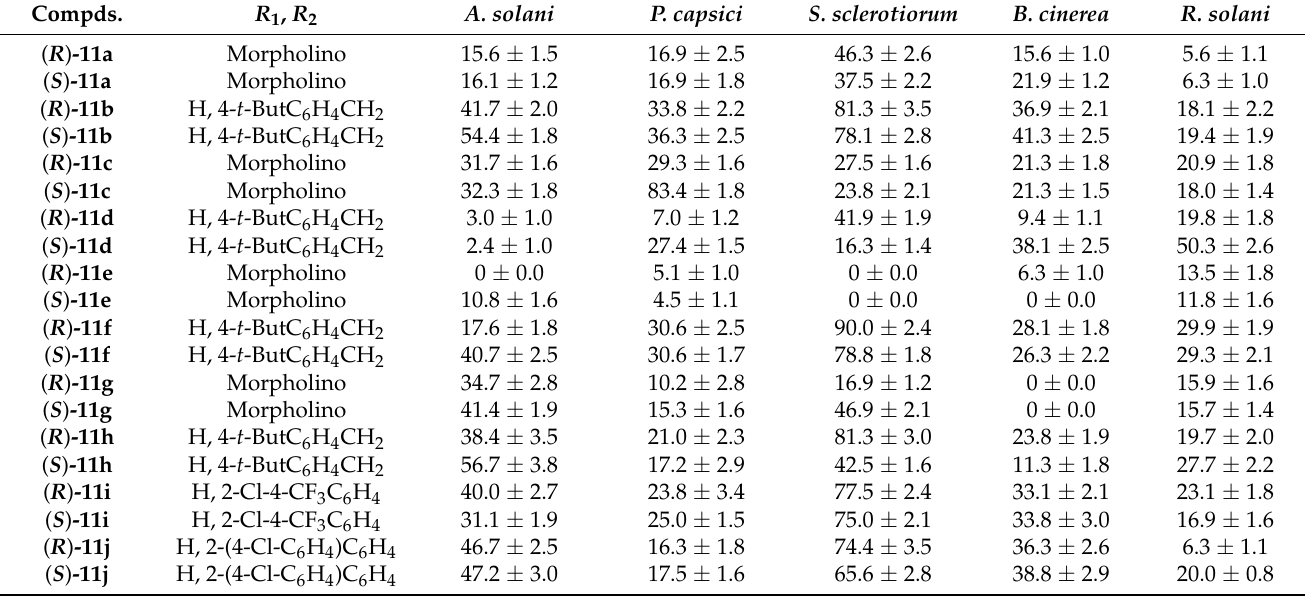
Table 1. The in vitro fungicidal activities of compounds 11a – 11p (inhibition rate %, 50 µ g/mL, p <